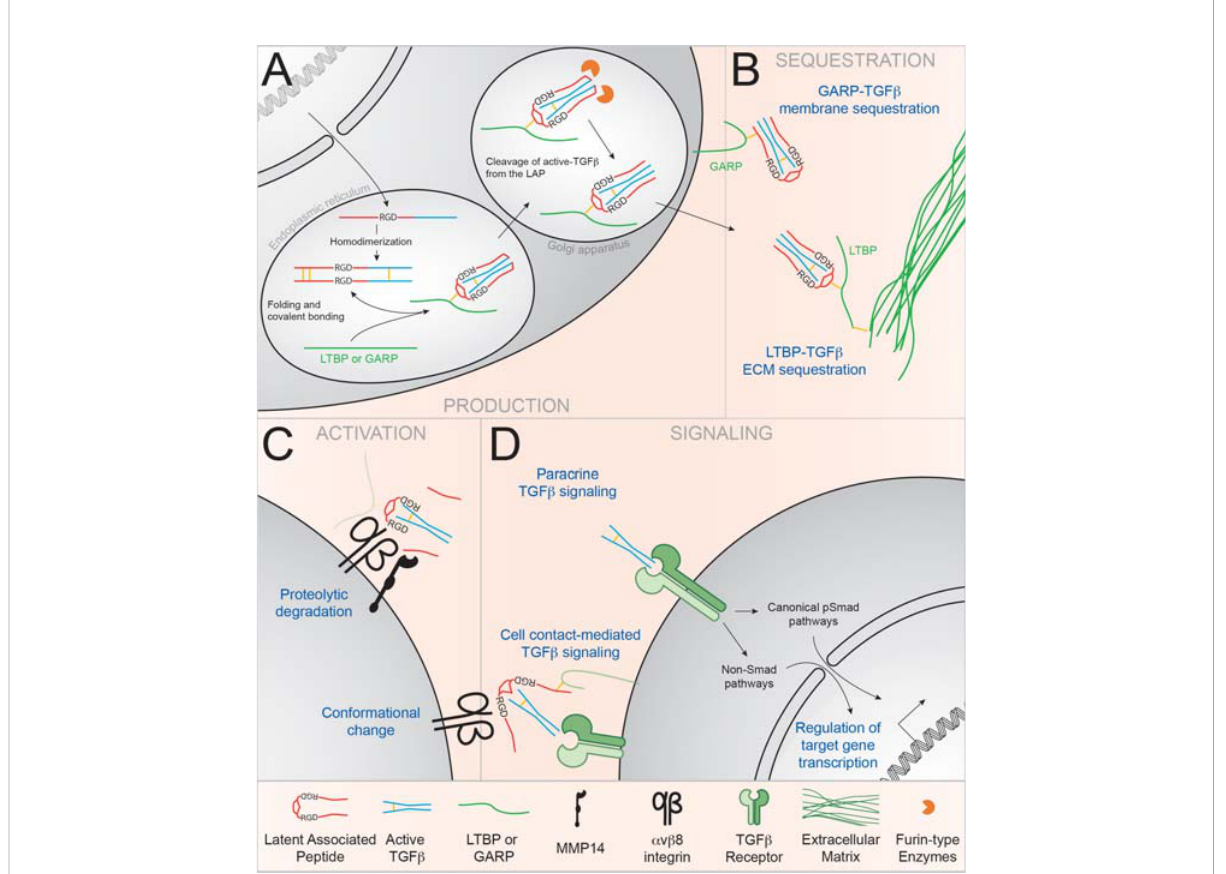
FIGURE 1 a b 8 integrins regulate TGF b bioavailability in the immune system. TGF b is produced by cells as an inactive complex and must be activated in v order to bind to its receptor and signal. (A) Transcription of TGF b produces a homodimeric propeptide containing the active TGF b molecule (blue) and the Latent Associated Peptide (LAP; in red). In the endoplasmic reticulum, association with the LTBP or GARP ‘ chaperone ’ proteins (green) enhances proper folding of the latent complex. In the Golgi apparatus, LAP-TGF b is cleaved by Furin-like enzymes, but active TGF b stays non-covalently bound to the LAP and forms the Small Latency Complex or latent TGF b (79) (B) Upon secretion, latent TGF b is sequestered to the ECM through binding of the LTBP or anchored at the plasma membrane by GARP. (C) Binding of a v integrins to the RGD tripeptide motif in the LAP induces the dissociation of TGF b from the LAP via the recruitment of metalloproteases such as MMP14 (78). Alternatively, conformational changes can allow TGF b binding to its receptor without the release of active TGF b (80). (D) TGF b binding to the TGF b